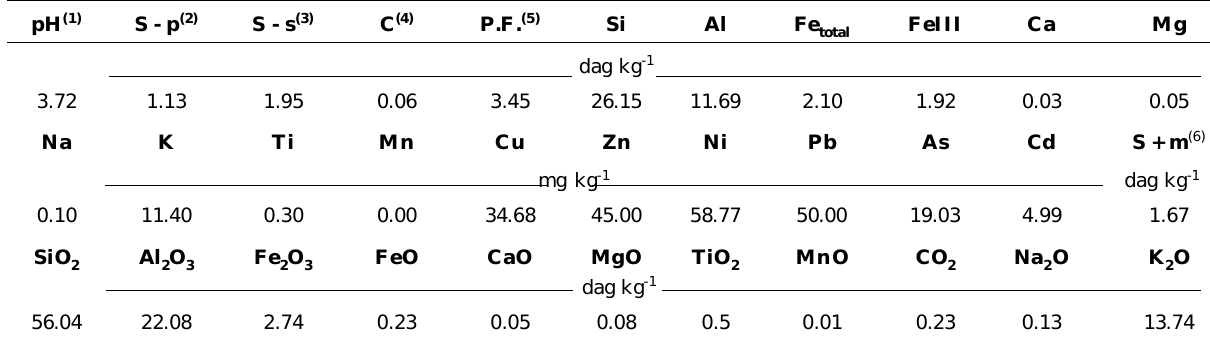
(1) pH measured in waste material of an uranium mine (substrate:water ratio 1:25, volume); (2) S - pyrite: S inferred by the production of titratable acidity. Digestion with